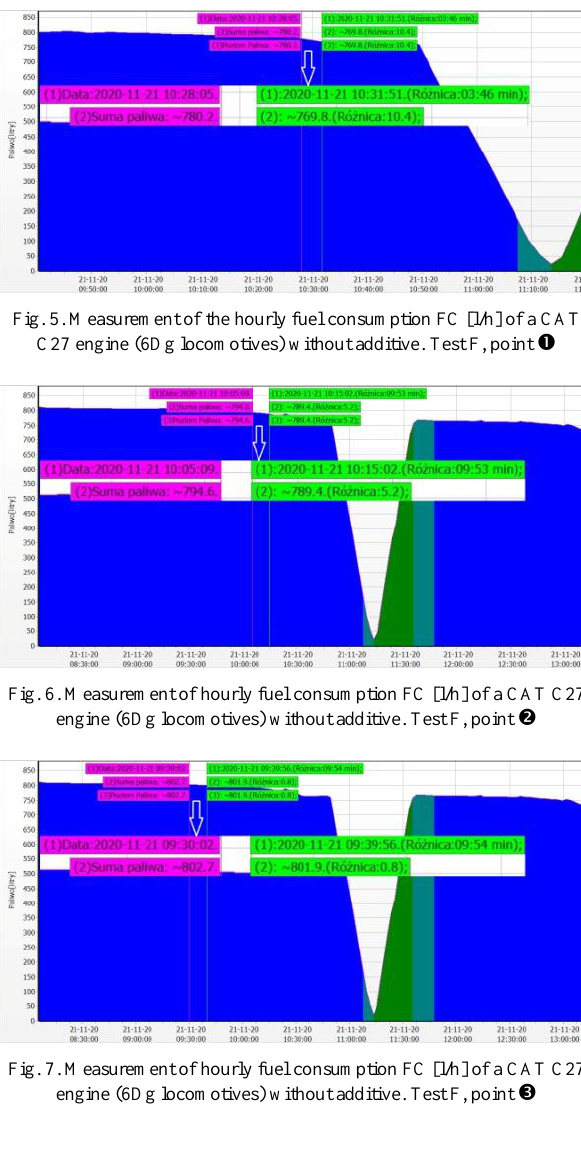
Fig. 1. Schematic of the F test run according to UIC 624 [4]